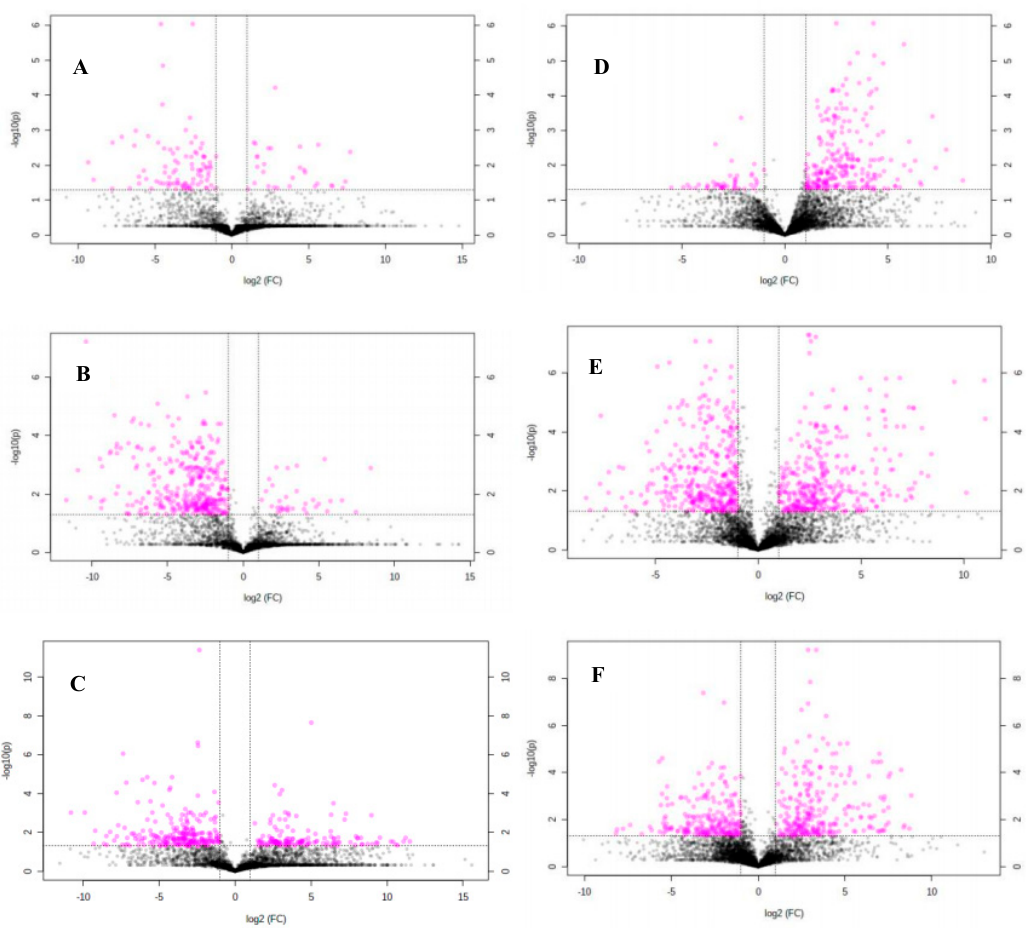
Figure 3. Metabolite volcano map in negative ion mode: ( A ) LPS vs. QF 0.1; ( B ) LPS vs. QF 1; ( C ) LPS vs. QF 10; metabolite volcano map in positive ion mode: ( D ) LPS vs. QF 0.1; ( E ) LPS vs. QF 1; ( F ) LPS vs. QF 10.